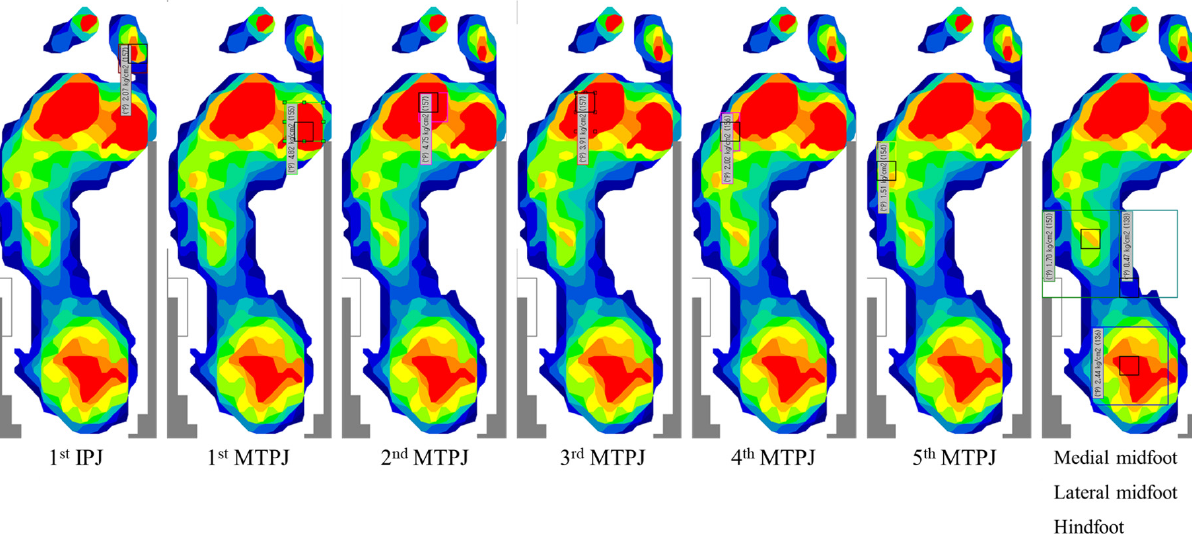
Figure 1. Plantar pressure measurement: IPJ = interphalangeal joint; MTPJ = metatarsophalangeal joint. Peak pressure was calculated at the following nine sections of interest, identified using radiography: the first IPJ, the first, second, third, fourth and fifth MTPJs, the medial midfoot, the lateral midfoot, and the